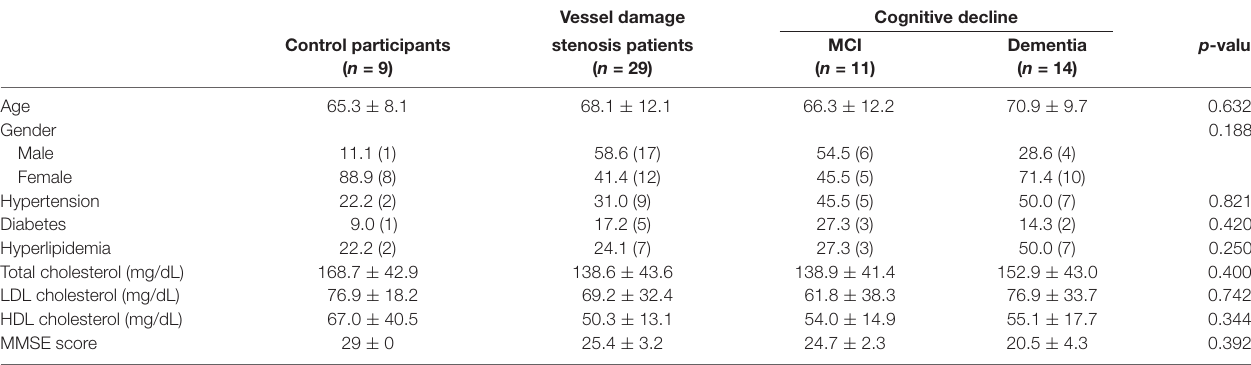
TABLE 1 | Patients characteristics.